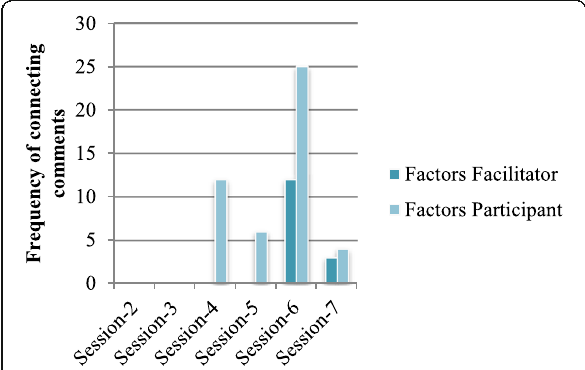
Fig. 3 Change in the frequency of connecting to factors comment across the PD